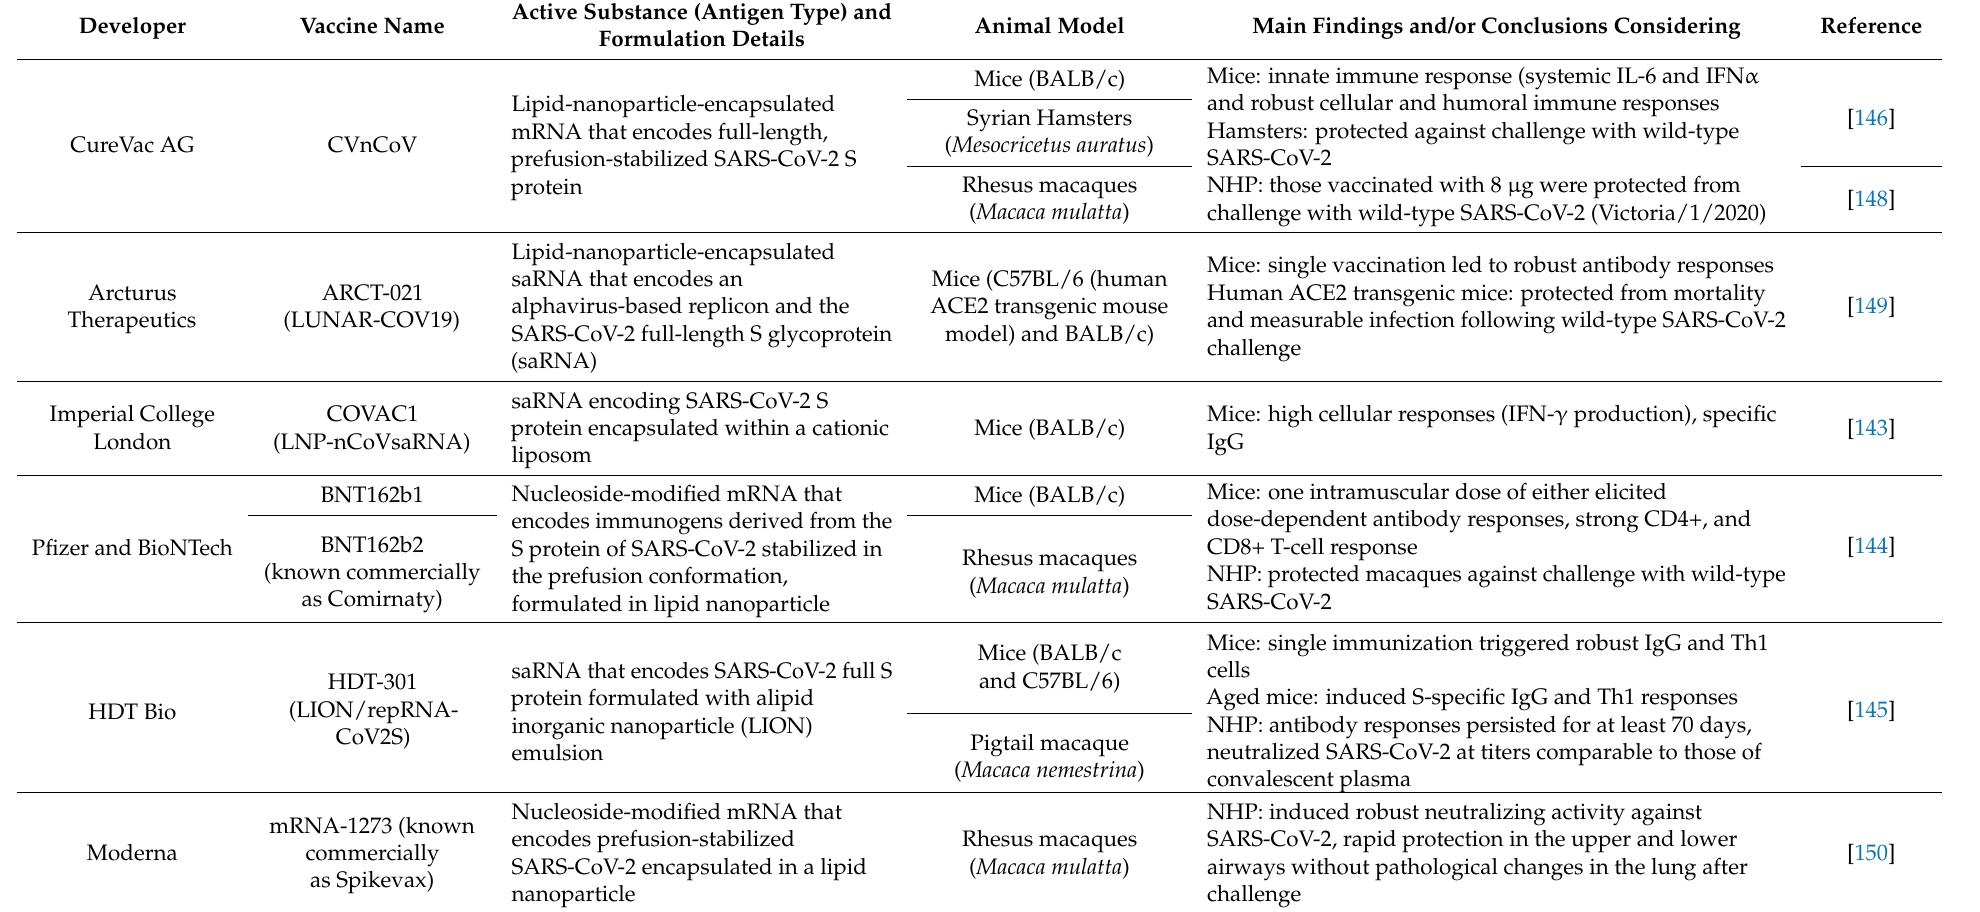
Table 3. Overview of preclinical studies of RNA-based COVID-19 vaccine